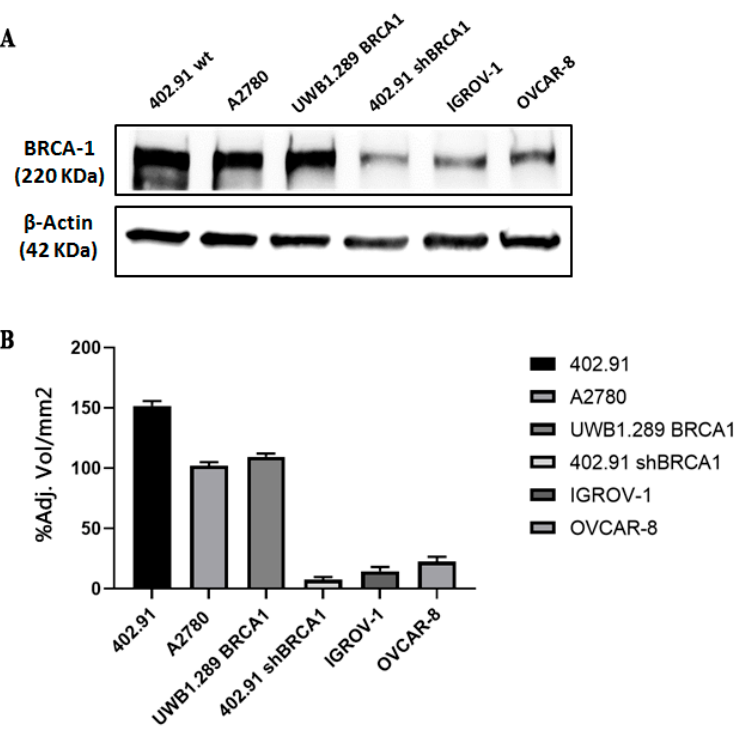
Figure 2. BRCA1 protein expression in cell lines. ( A ) Representative Western blot analysis of BRCA1 expression in BRCA1 proficient (402.91 wild type (wt), A2780, UWB1.289 BRCA1) and BRCA1 defective cells (BRCA1 stable silenced 402.91 (402.91 shBRCA1), IGROV-1 and OVCAR-8). β -actin was used as loading controls. ( B ) Densitometric analysis of protein band intensity normalized on housekeeping controls expressed as mean value of three replicates ± standard deviations of the percentage of adjusted volume/mm 2 .